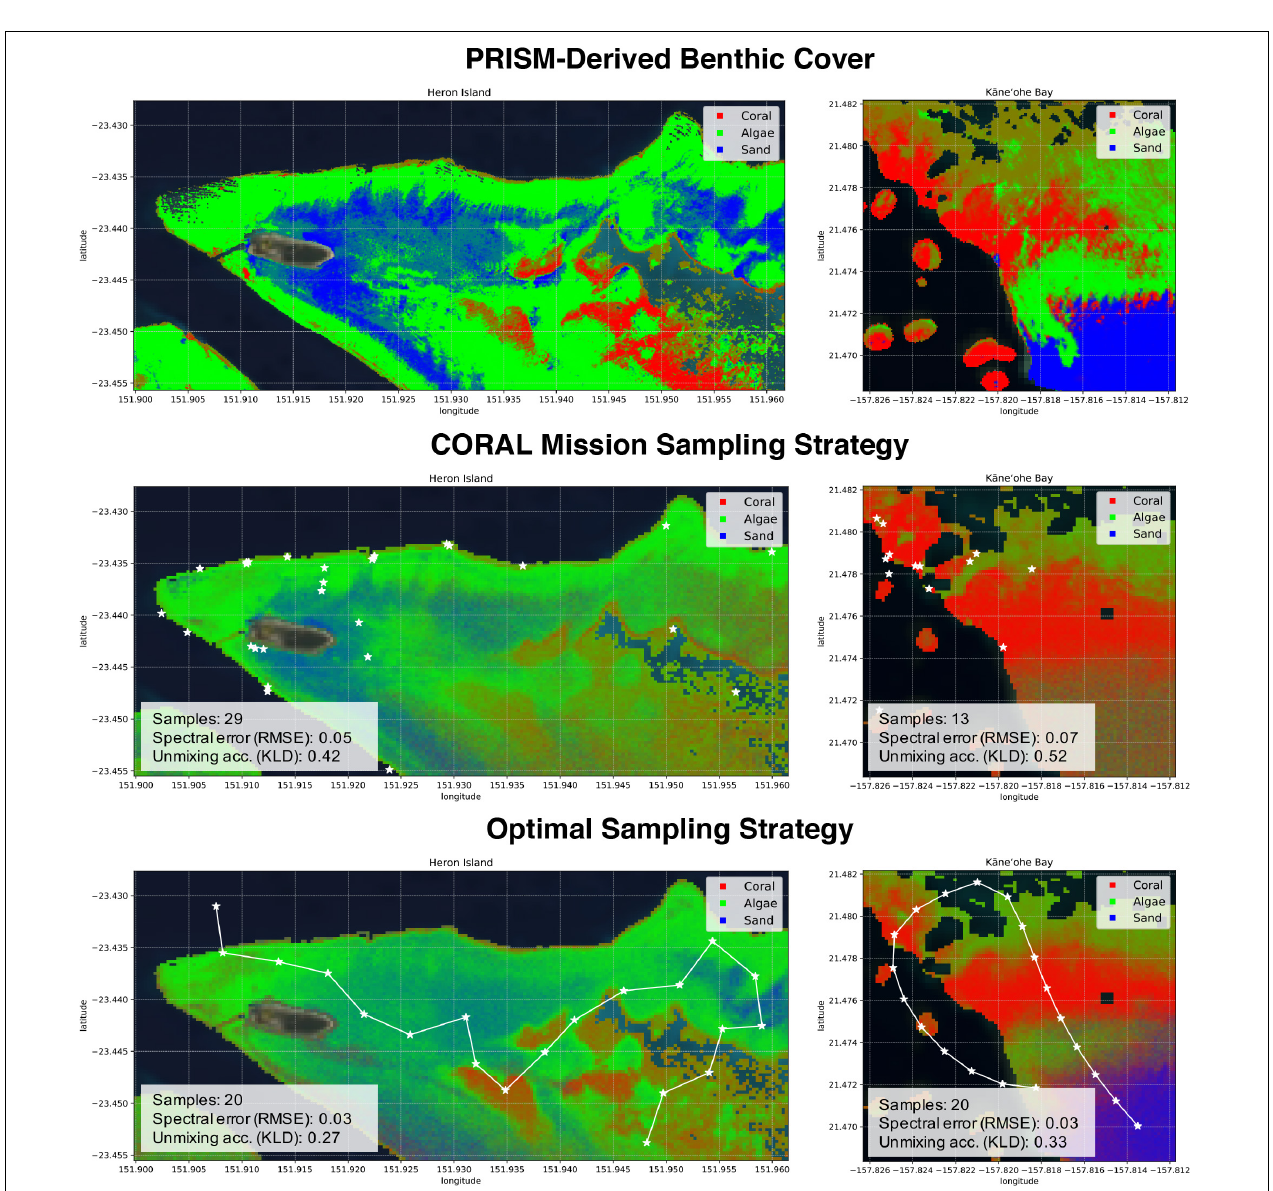
FIGURE 10 | Experimental setting for the simulation study. A subregion of 6 × 3 km in Heron Island is shown on the left, whereas a region of 1.5 × 1.5 km in Kaneohe Bay appears on the right. Top row: abundance maps estimated by Thompson et al. (2017) and validated by the CORAL mission, serving as the ground truth in this study. Middle row: predicted abundances using the sampling strategy followed during the CORAL mission. Bottom row: predicted abundances using paths generated by two optimal sampling strategies, Maximum Information Gain (left) and Spectral Multi-scale Coverage (right). White asterisks indicate sampling locations. In this example, the optimal sampling strategies produce more accurate maps both as a function of spectral reconstruction error, in terms of Root Mean Squared Error (RMSE), and unmixing accuracy, in terms of the Kullback–Leibler Divergence (KLD).